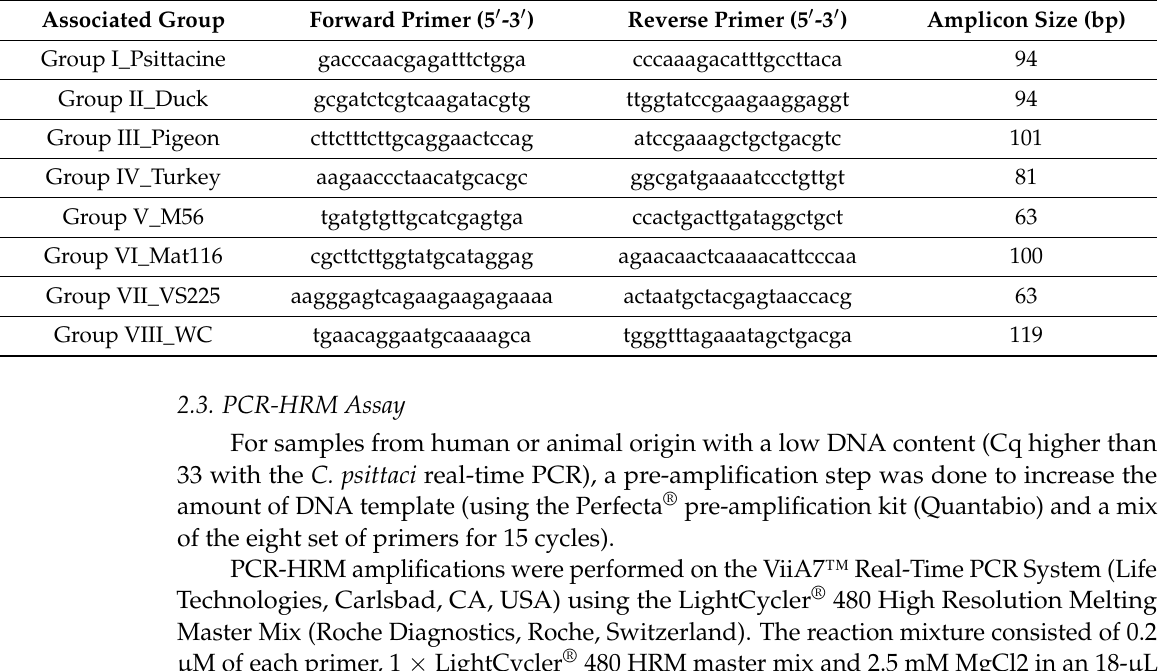
Table 3. PCR primers used for the PCR-HRM